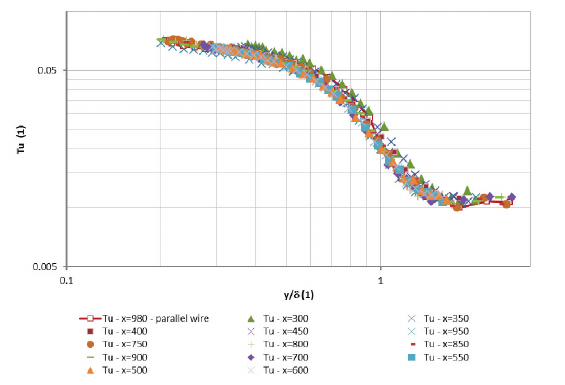
Fig. 8 Dimensionles emperature profiles